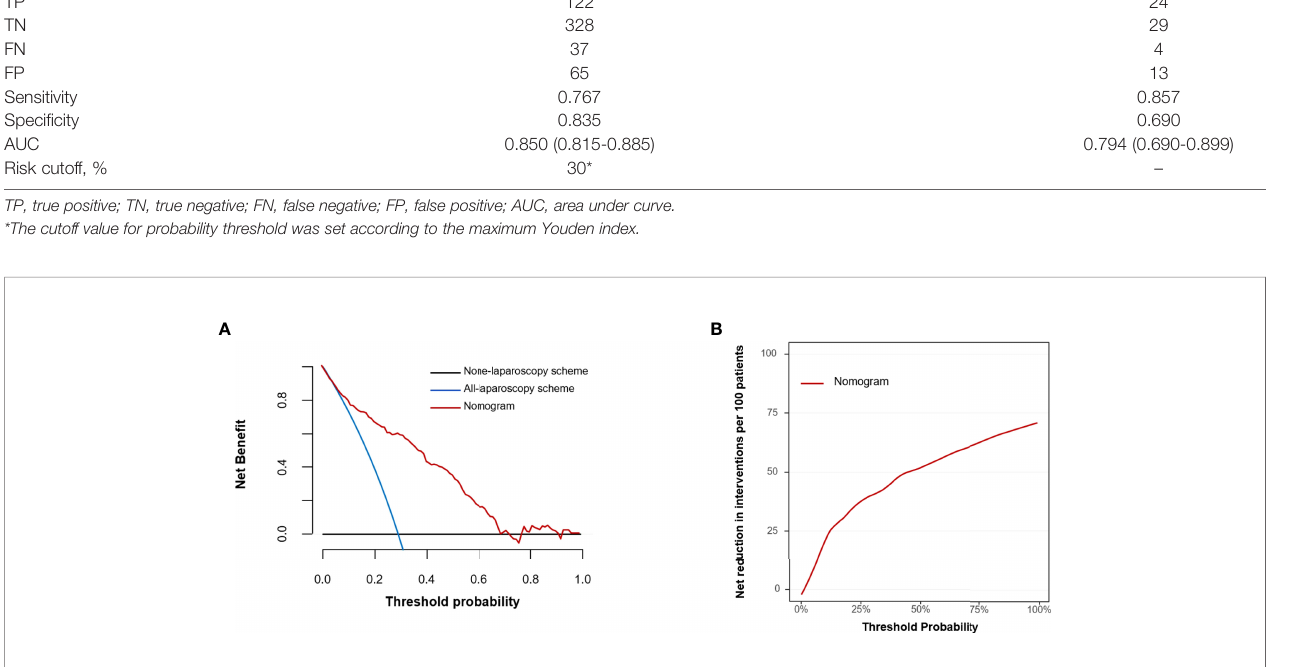
FIGURE 5 | Decision curve analysis for the prediction model. (A) Net bene fi t. (B) Net